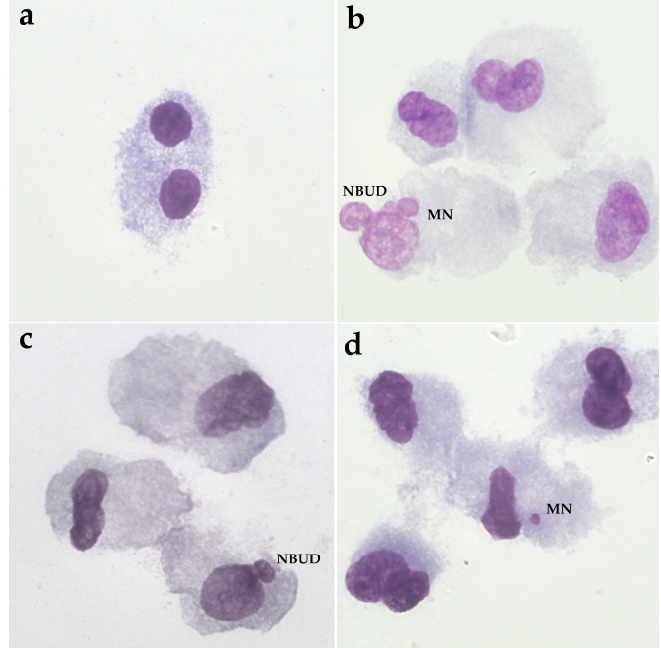
Figure 4. CBMN assay in the Hs27 cells: DNA damage after PNP treatment. ( a ) Binucleated cell, ( b ) cell with micronuclei and nuclear bud, ( c ) cell with nuclear bud, ( d ) cell with micronuclei. Magnification 100×.